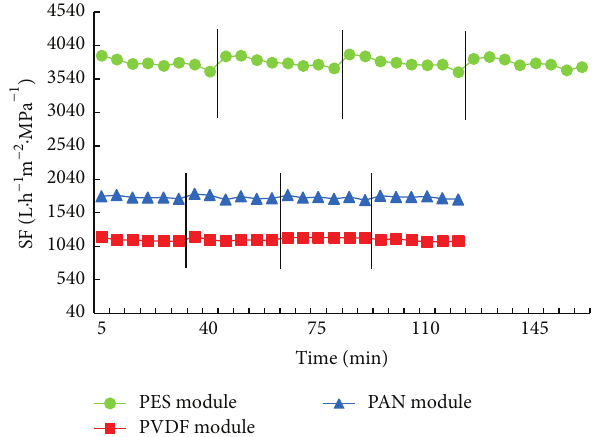
Figure 6: SF trends of various UF modules in four filtration dura-